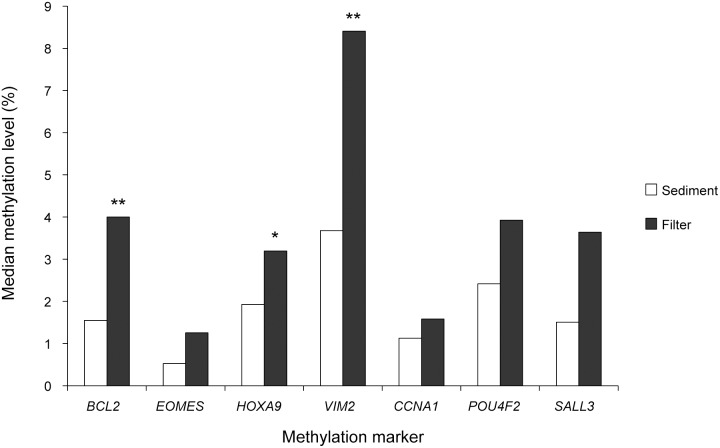
Levels of DNA methylation in paired urine samples (sediment and filter) from patients with bladder cancer (N = 189).Shown is the median of normalized values (percent methylated reference, PMR) from MethyLight analysis of seven methylation markers. For each marker, the methylation levels ranged from <1% to 100% (not shown). *, p<0.05; **, p<0.01.